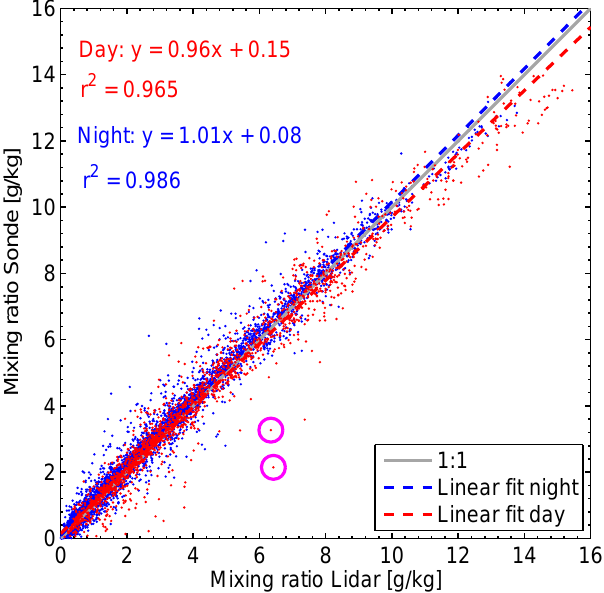
Fig. 9. Water vapor mixing ratio correlation plot between lidar and radiosondes for night (blue) and day (red) for all altitude levels (day: 2239 points, night: 6887 points). Magenta circled points are references for discussion in the paper. Only clear-sky days are considered. Period: 1 October 2009 to 30 September 2010.